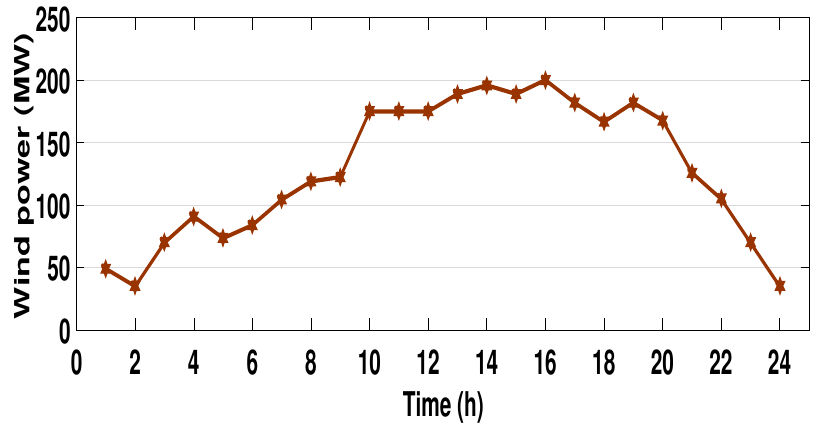
Figure 9. Wind output power.